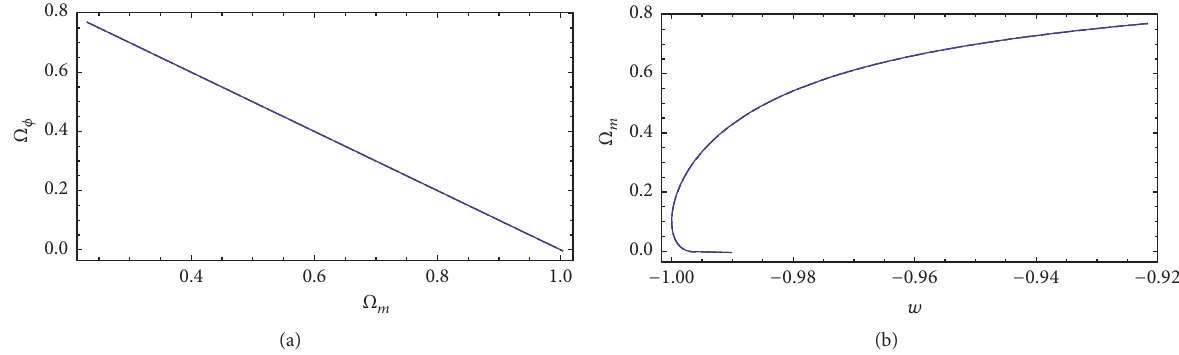
Figure 13: Variation of the density parameter of the tachyonic scalar field with power law potential as a function of the density parameter of the dust cosmological matter ( 𝛾 𝑚 = 1 ) (a) and of the parameter 𝑤 of the total equation of state (b) for different values of 𝛼 : 𝛼 = 0.8 (solid curve), 𝛼 = 1 (dotted curve), 𝛼 = 1.2 (dashed curve), and 𝛼 = 1.4 (dashed dotted curve), respectively.